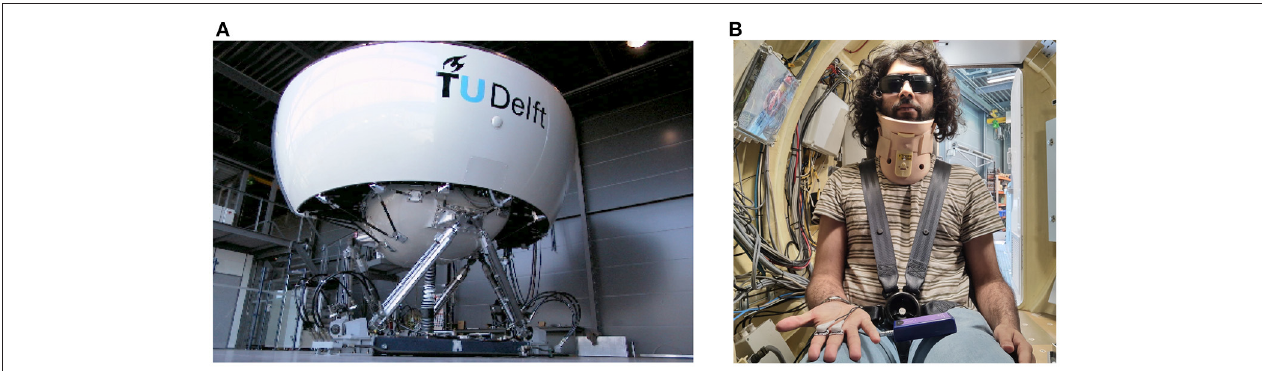
FIGURE 1 | Experimental setup. (A) is the SIMONA Research Simulator used in the experiment to elicit motion sickness via fore-aft sinusoidal motions of differing amplitudes. (B) shows the second author as a participant in the experiment, wearing a 5-point safety harness, a neck restraint, and blackened